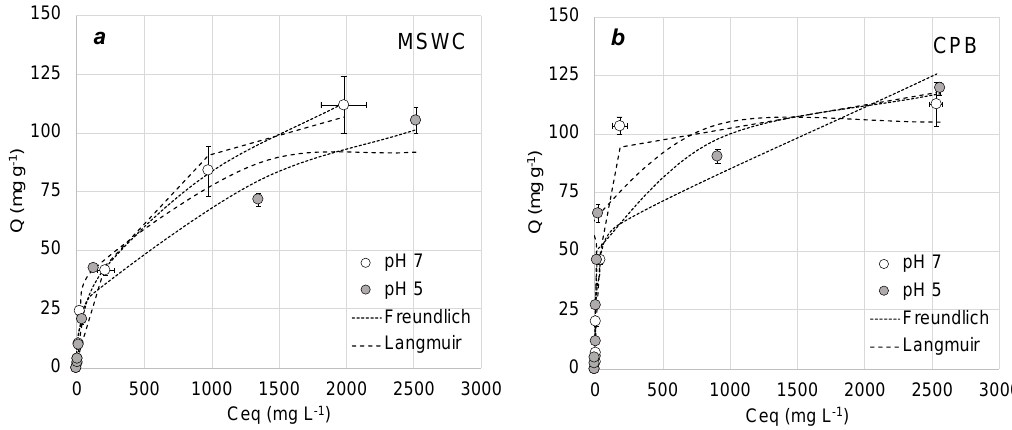
Figure 5. Adsorption curves at different pH for ( a ) municipal solid waste compost (MSWC) and ( b ) composted pine bark (CPB). Bars show standard deviations of the mean (n = 3). Table 3. Adsorption model parameters under di ff erent conditions (estimation ± standard error). MSWC: municipal solid waste compost; CPB: composted pine bark. K F (L n µ mol 1 − n kg − 1 ), 1 / n